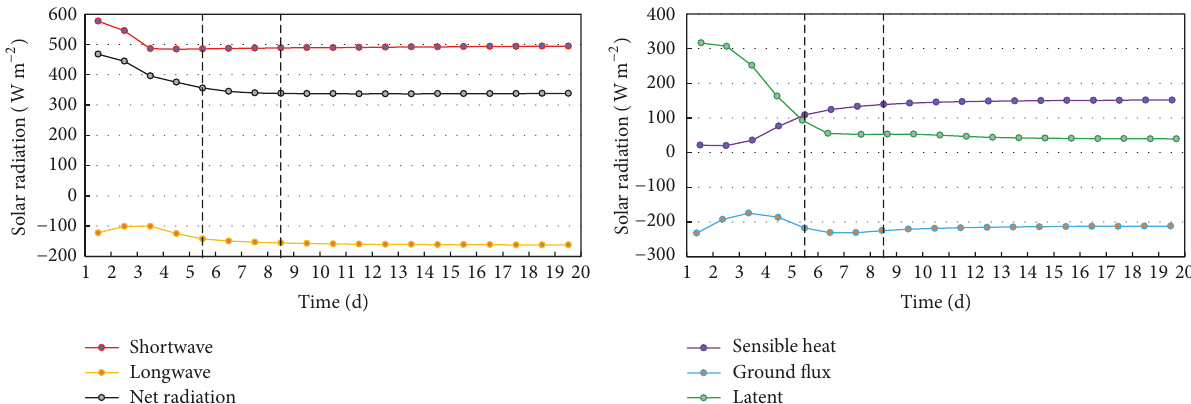
Figure 7: Diurnal maximum values of surface energy balance components depicted in Figure 4 (for 𝑅 ns and 𝐿𝐸 , negative diurnal maximum values are demonstrated).